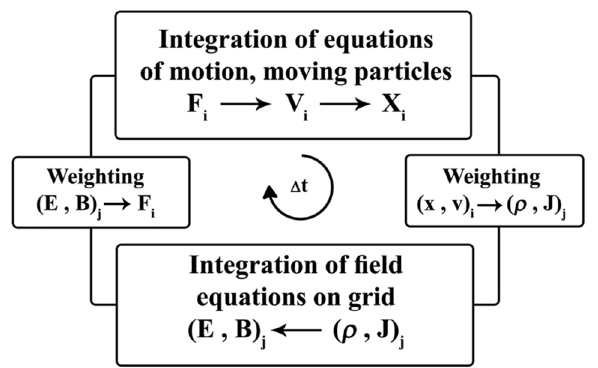
Figure 1. A flow chart of the processes involved in one timestep of the particle-in-cell method. This algorithm is discussed in 27